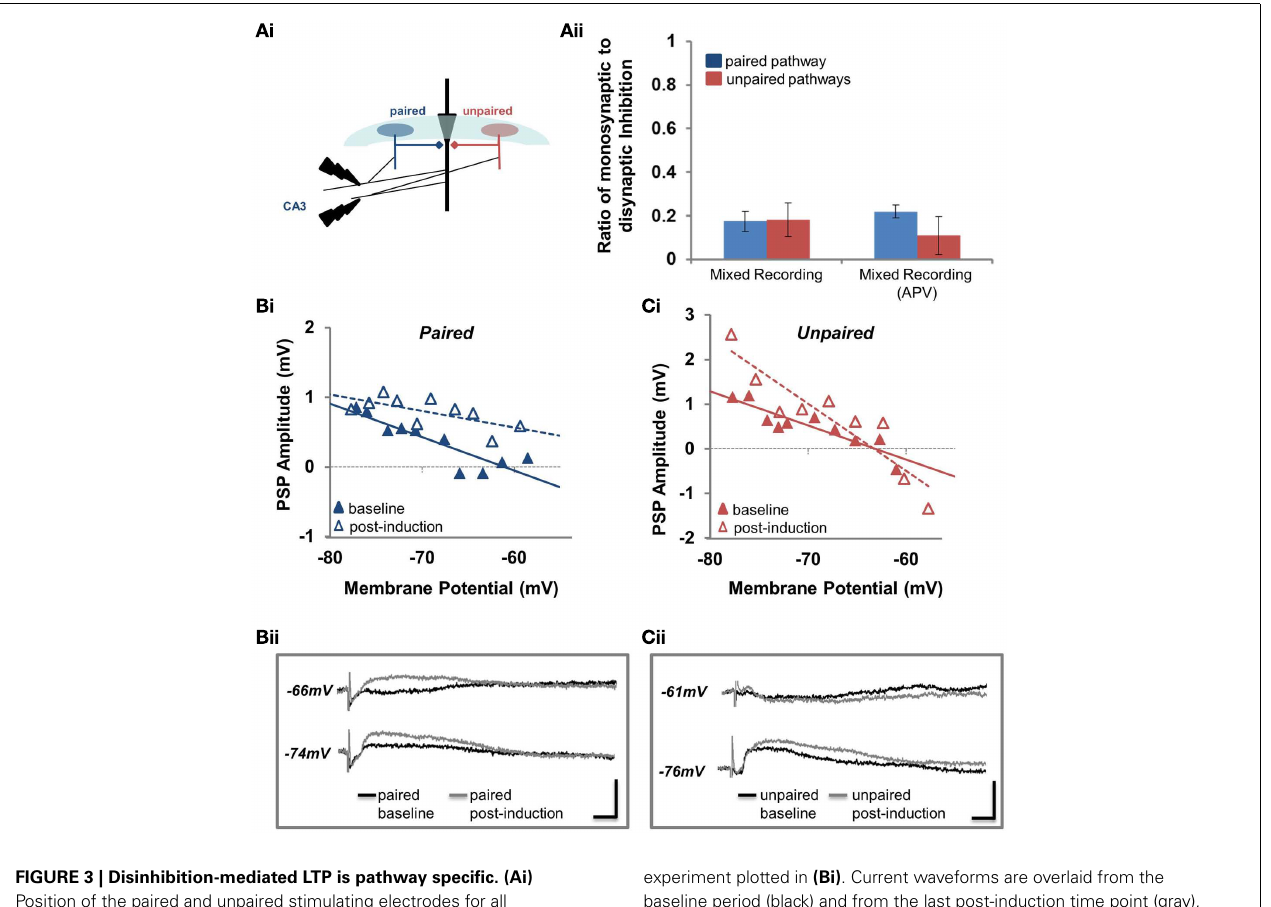
FIGURE 3 | Disinhibition-mediated LTP is pathway specific. (Ai) Position of the paired and unpaired stimulating electrodes for all experiments where inhibition was stimulated disynaptically. (Aii) The ratio of monosynaptic to disynaptic inhibition (see Materials and Methods for details) at the paired (blue) and unpaired (red) pathways for disinhibition-mediated LTP (mixed recording) experiments performed in the absence and presence of APV. (Bi) PSP amplitude is plotted against V m for the paired pathway before (baseline; solid blue triangles) and after pairing (post-induction; open blue triangles). (Bii) Sample traces from the